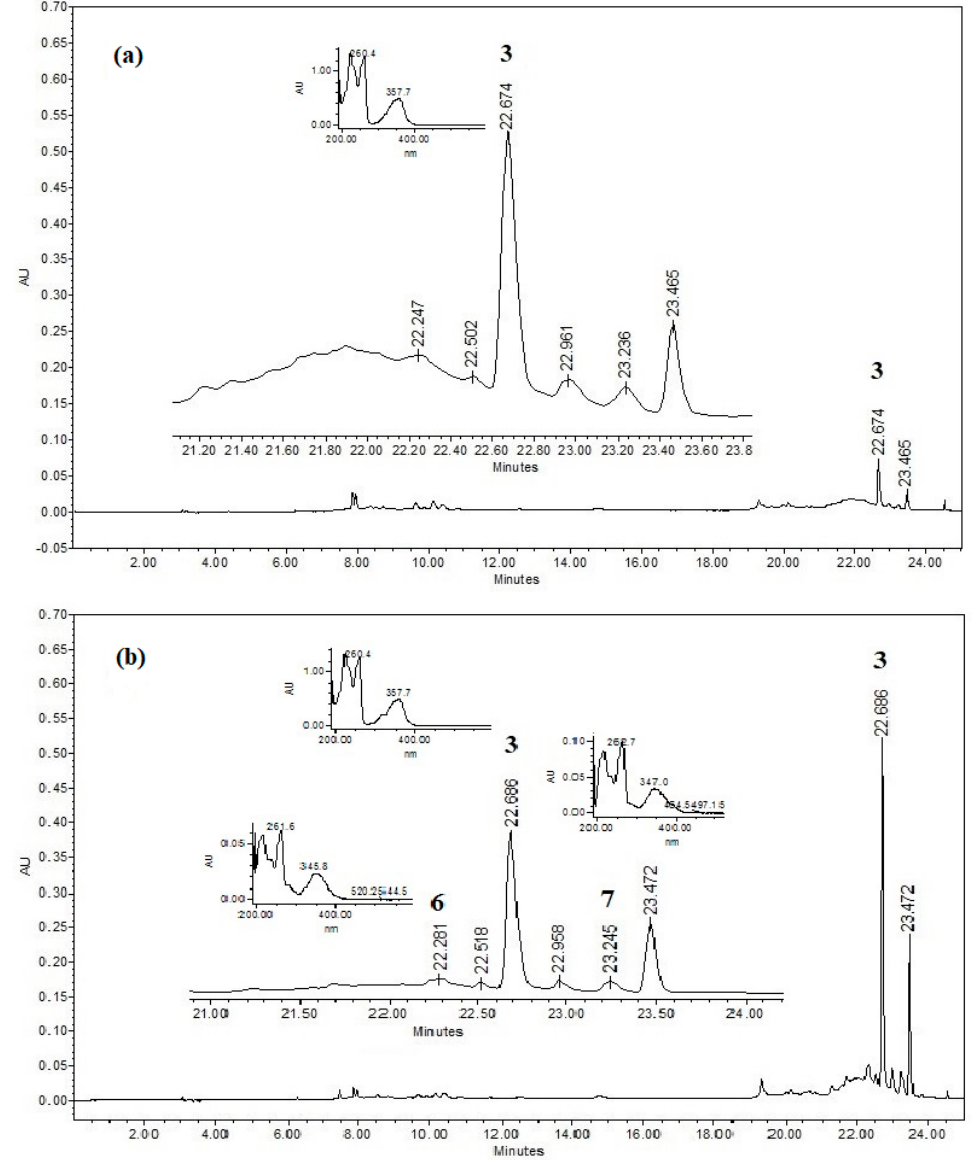
Figure 2. Chromatograms of dichloromethane–methanol extracts from the ( a ) SaTRN12.2 (line 1, 3 mg/mL) and ( b ) SaTRN7.1 (line 2, 0.3 mg/mL) hairy root lines of S. angustifolia at λ = 357 nm. It should be noted that in line 1, the compounds were not detected at a concentration of 0.3